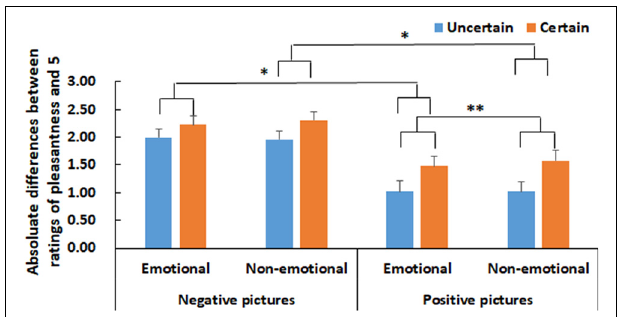
FIGURE 2 | Absolute differences between pleasantness ratings and the neutral value (i.e., 5) for pictures in each experimental condition. Vertical lines indicate the SE of the mean. The significance level of the effect of cue uncertainty is marked by the number of “*” symbols. “ ∗ ” and “ ∗∗ ” indicate p < 0.05 and 0.01,